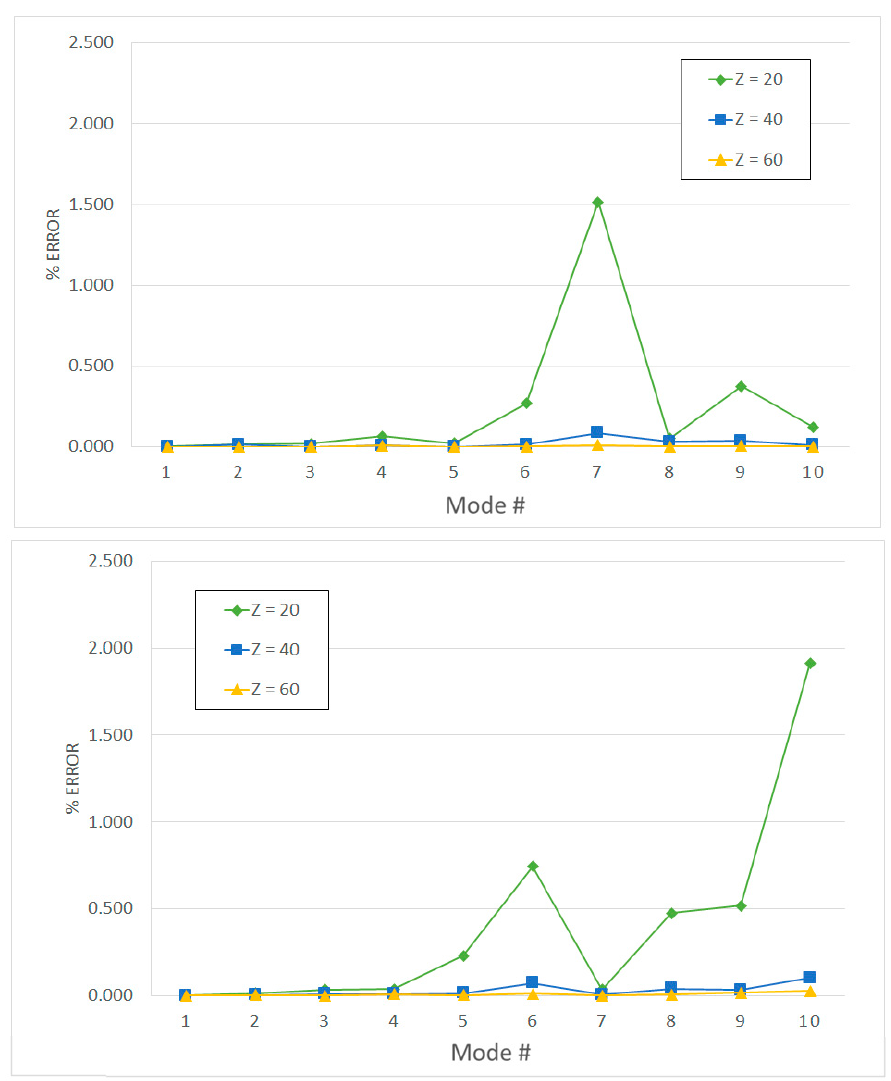
Figure 4. Test Case A (linear elements)—accuracy of the direct method for h = 1 (Up) and h = 13 (Low).